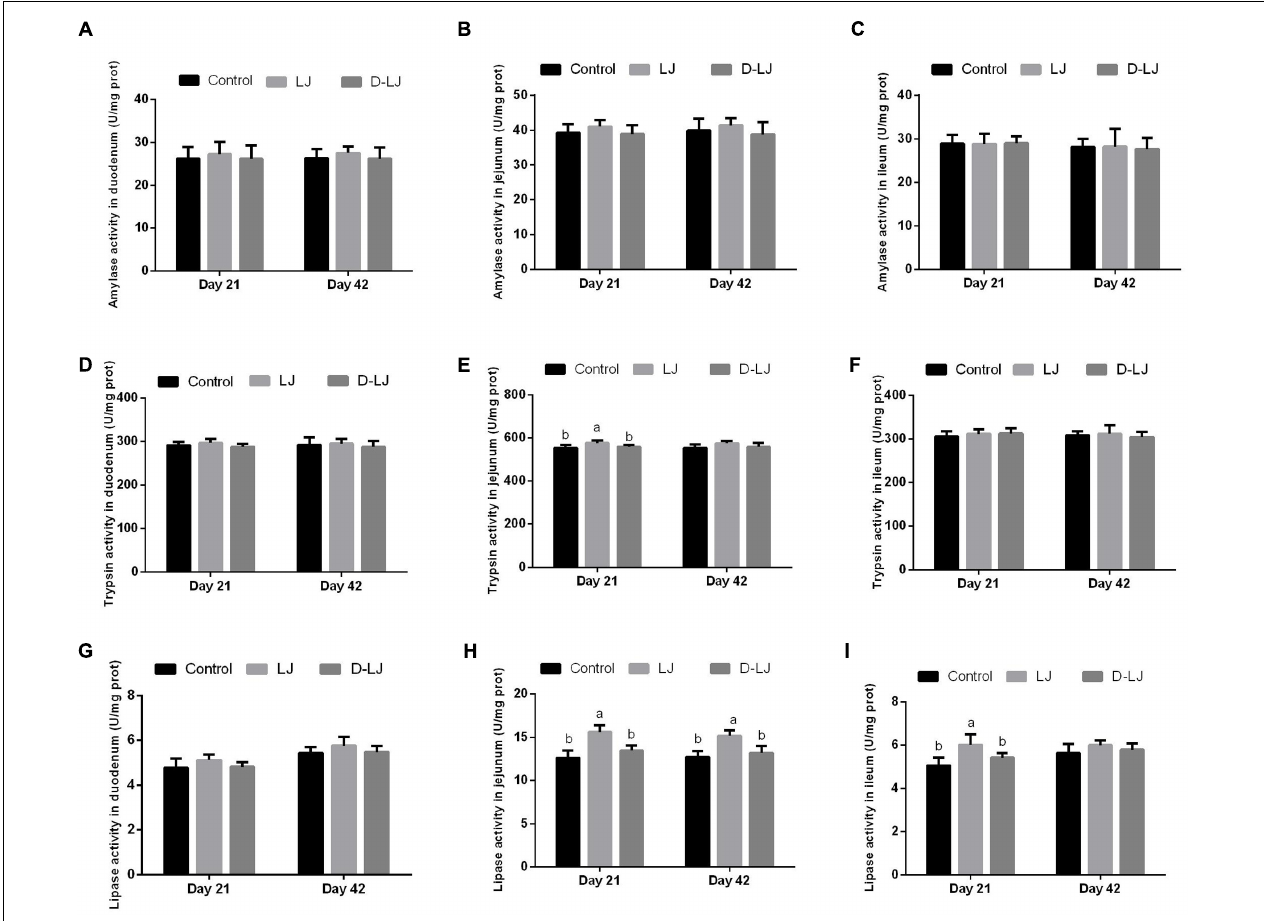
FIGURE 6 | Levels of amylase, trypsin, and lipase activities in the small intestine. Bars with different letters are significantly different on the basis of Duncan’s multiple range tests ( P < 0.05). Data are presented as mean ± standard deviation (six replicates of one chick per cage). (A–C) Amylase activity in the duodenum, jejunum, and ileum; (D–F) trypsin activity in the duodenum, jejunum, and ileum; and (G–I) lipase activity in the duodenum, jejunum, and